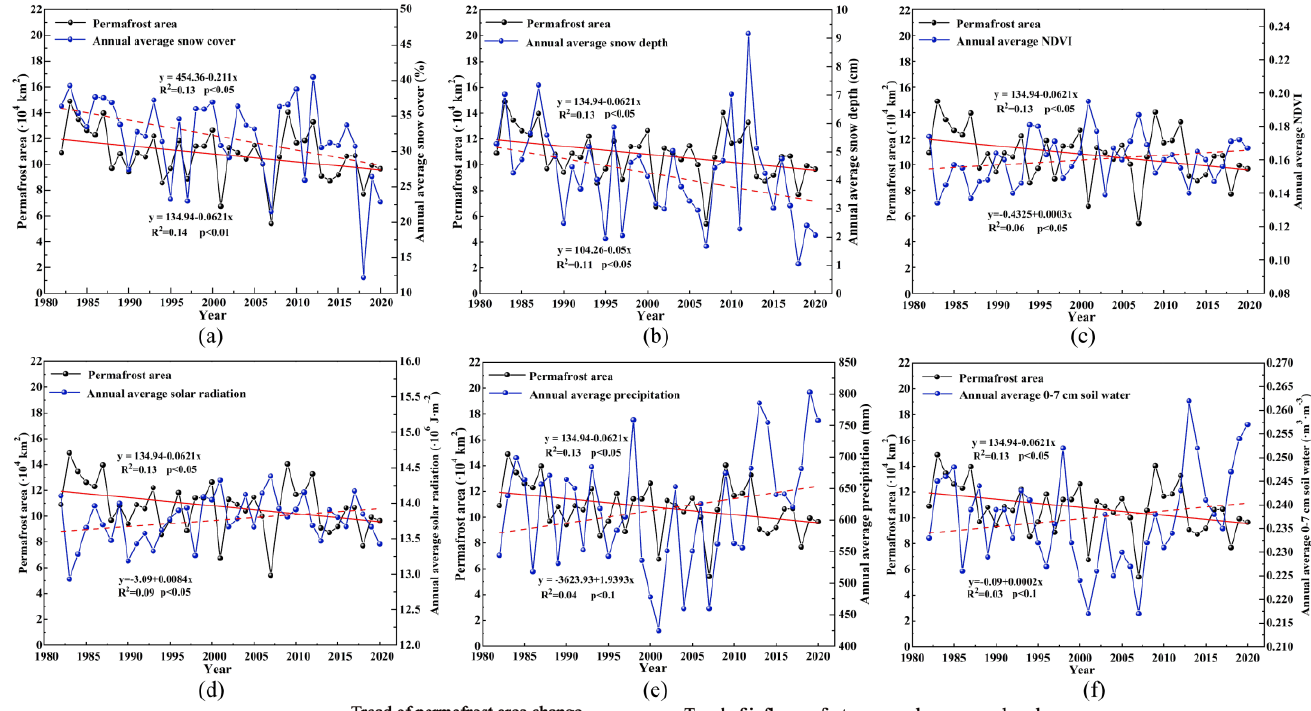
Figure 6. Time trends of influencing factors: ( a ) annual average snow cover; ( b ) annual average snow depth; ( c ) annual average NDVI; ( d ) annual average solar radiation; ( e ) annual average precipitation; ( f ) annual average 0 – 7 cm soil water content.